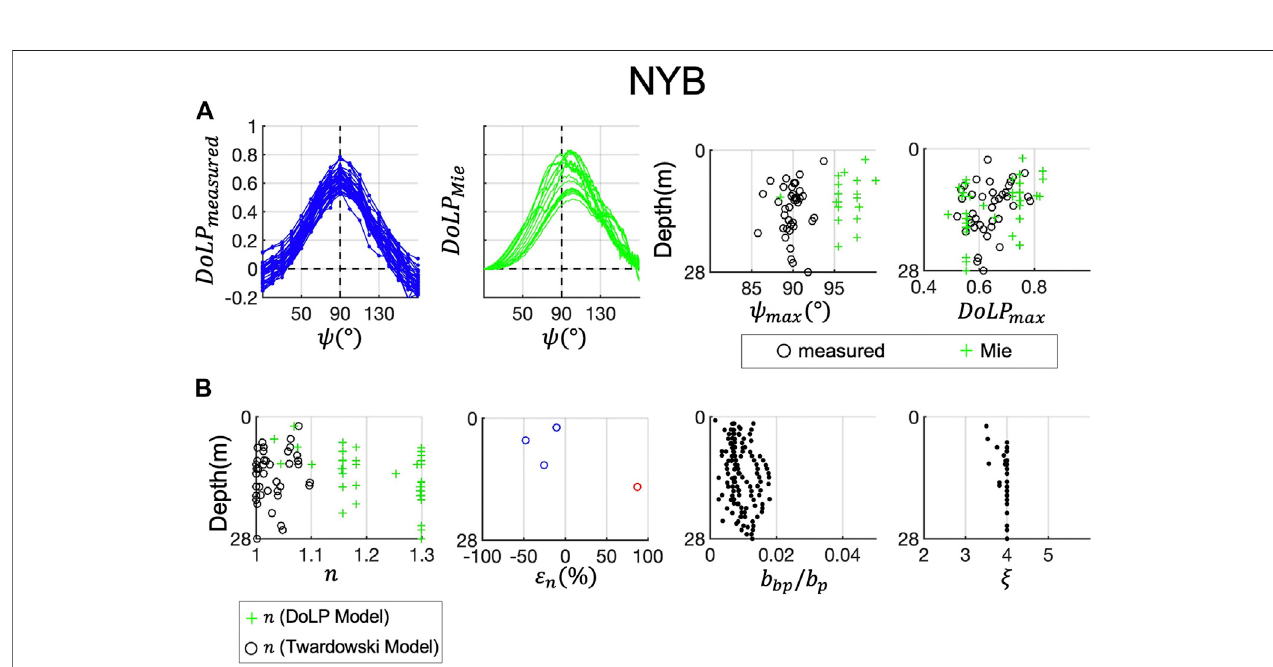
FIGURE 13 | Refractive index retrieval at fi eld site NYB (New York Bight). Same as Figure 9 .